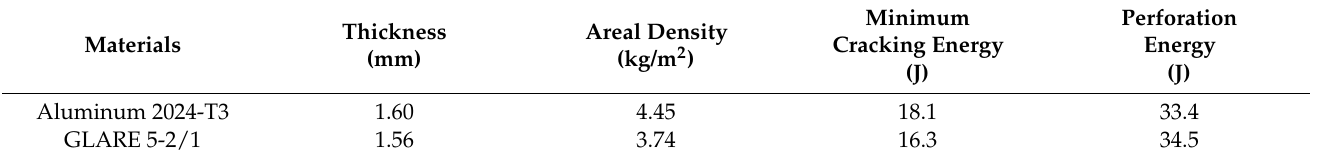
Figure 10. Irreversible central deflection as a function of the impact energy. Table 4. Minimum cracking energy and perforation energy for GLARE laminates [6].